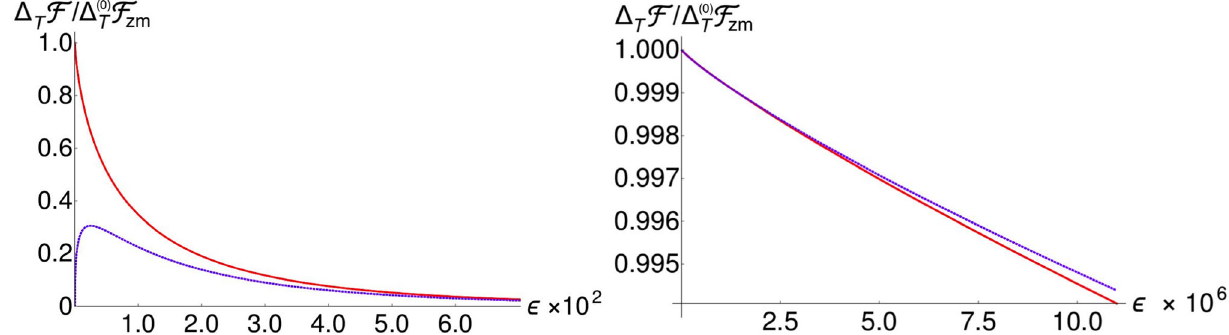
F (A.14) (dashed line in blue, RIGHT) and Eq. (A.15) (dashed line in zm as a function of T blue, LEFT). The numerical values are T = 1, L = 0 . 1, and a = 0 .